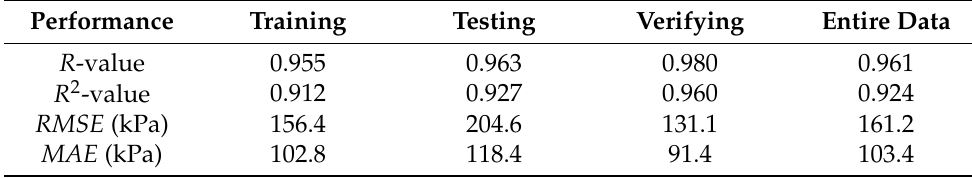
Table 4. Performance of the proposed